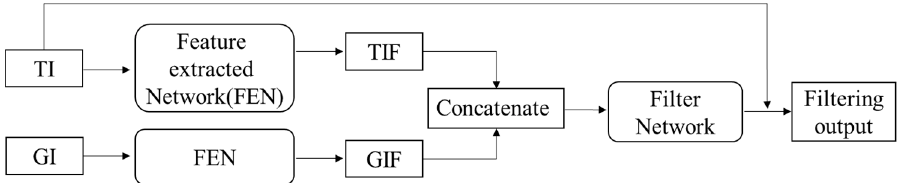
Figure 13. The network architecture in reference [28]. TI, GI, TIF, and GIF refer to target image, guidance image, target image feature, and guidance image feature, respectively.